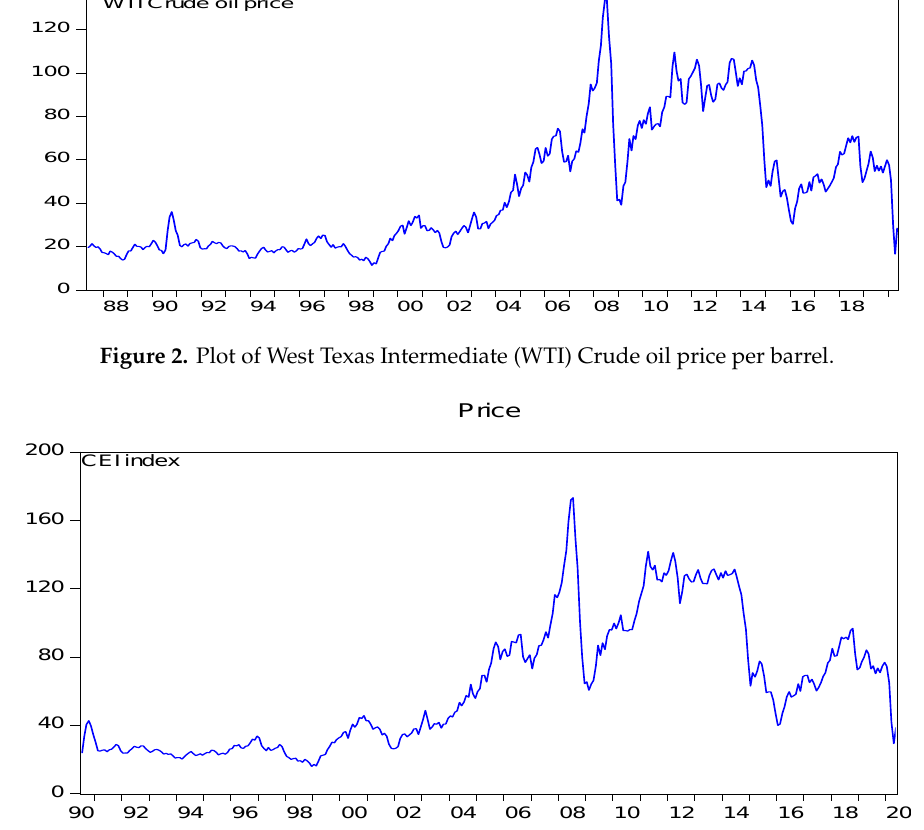
Figure 3. Plot of commodity (fuel) energy index (CEI).